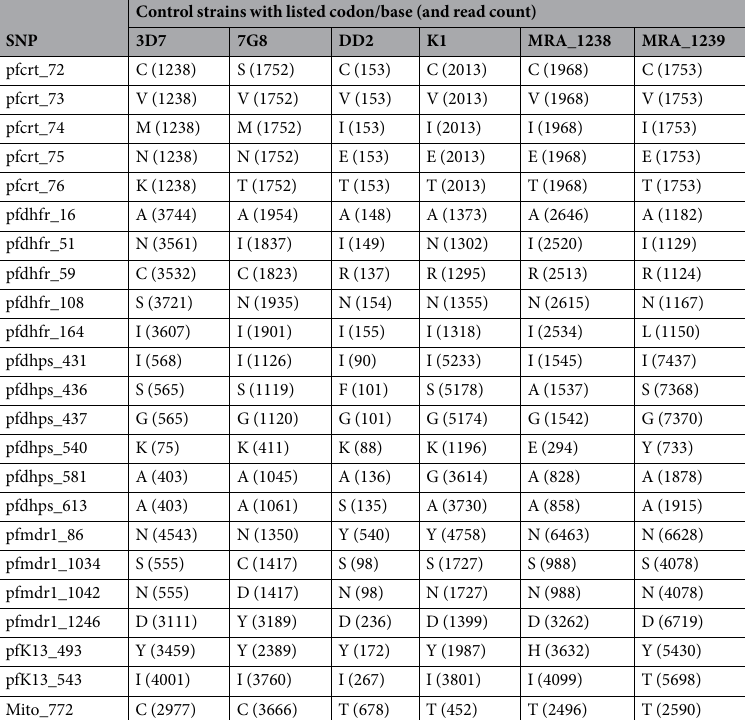
Table 5. Control data. The table lists the acquired data for the control parasites. The data is listed as the acquired codon/base (only base for Mito_772, as the mitochondrial barcode is DNA-code based) followed by the amount of matching reads in parenthesis. None of the control samples were mixed